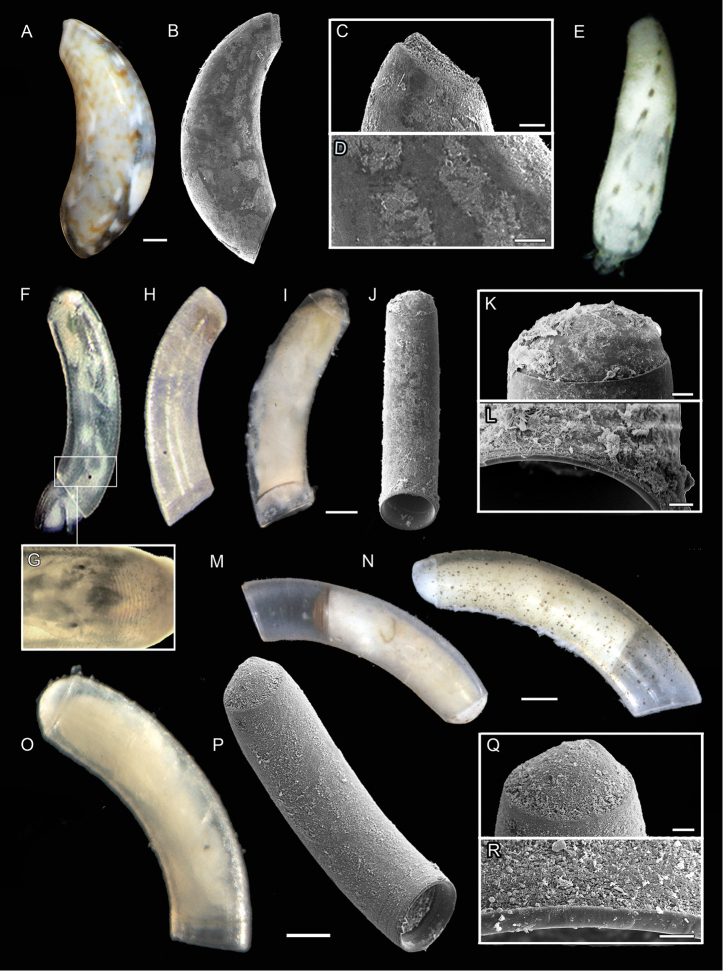
A–DMeioceras
nitidum, specimen MNHN-IM-2013-72087 A light microscopic picture BSEM scan CSEM close-up of mucro and D microsculpture EM.
cubitatum, specimen USNM 1618851 F, GC.
cf.
corrugulatum, specimen USNM 1618861 F light microscopic picture G light microscopic close-up of microstructure H MOTU II, specimen USNM 1618853 I–L MOTU I, specimen ZSM-Mol-20200039 I light microscopic picture JSEM scan KSEM close-up of mucro and L microsculpture MC.
glabrum, specimen ZSM-Mol-20200096 NC.
glabellum auctt. non Adams, specimen ZSM-Mol-20200074 O–RC.
invisibile sp. nov., holotype ZSM-Mol-20100320 O light microscopic picture PSEM scan QSEM close-up of mucro and R microsculpture. Scale bars: 10 µm (R); 20 µm (C, K, L, Q); 50 µm (D, E) 100 µm (I, J, O, P); 200 µm (A, B, M, N).